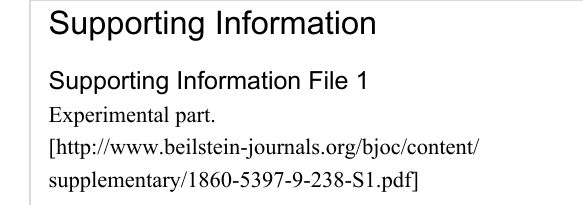
varying concentrations of alanine, glutamine, lysine, tyrosine, methionine and histidine. As expected, the amino acids lacking functionality known to quench fluorophores (alanine, gluta- mine and lysine) did not quench NBDM at concentrations as high as 50 mM. Interestingly, tyrosine did not quench NBDM fluorescence even at concentrations as high as 2 mM (solubility limit for tyrosine). Methionine and histidine, however, did quench NBDM via a dynamic mechanism (Figure 4).